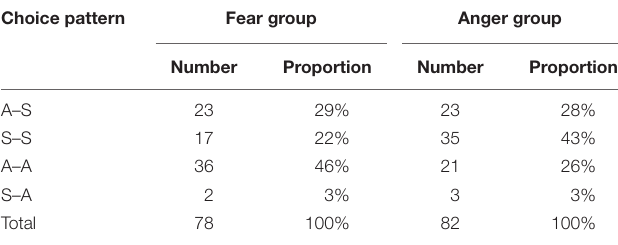
TABLE 6 | Choice patterns across gain and loss frames.